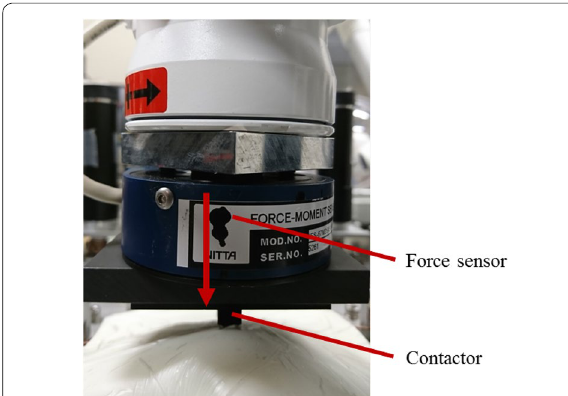
Fig. 10 Measurment of the elasticity in normal direction of the reproduced shape